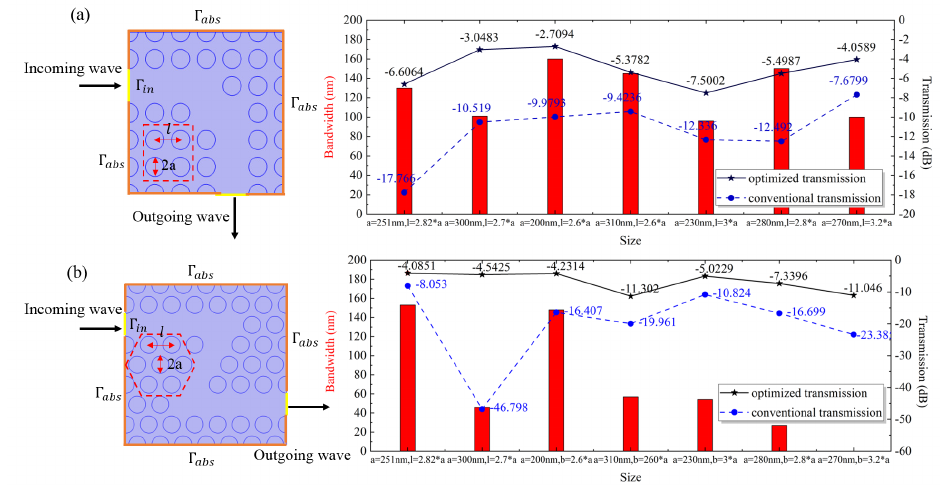
Figure 5. Transmission spectra of curved PCW with different structures at different sizes. ( a ) Rectangular 90 ◦ bending PCW; ( b ) triangular lattice structure Z curved PCW. The transmis- sion spectrum shows the transmission-loss bandwidth of less than − 6 dB after topology optimization of different sizes from 1440 nm to 1600 nm. The blue dashed line shows the transmission loss of conventional transmission at 1550 nm at different sizes; the solid black line shows the transmission loss at 1550 nm for optimized transmission at different